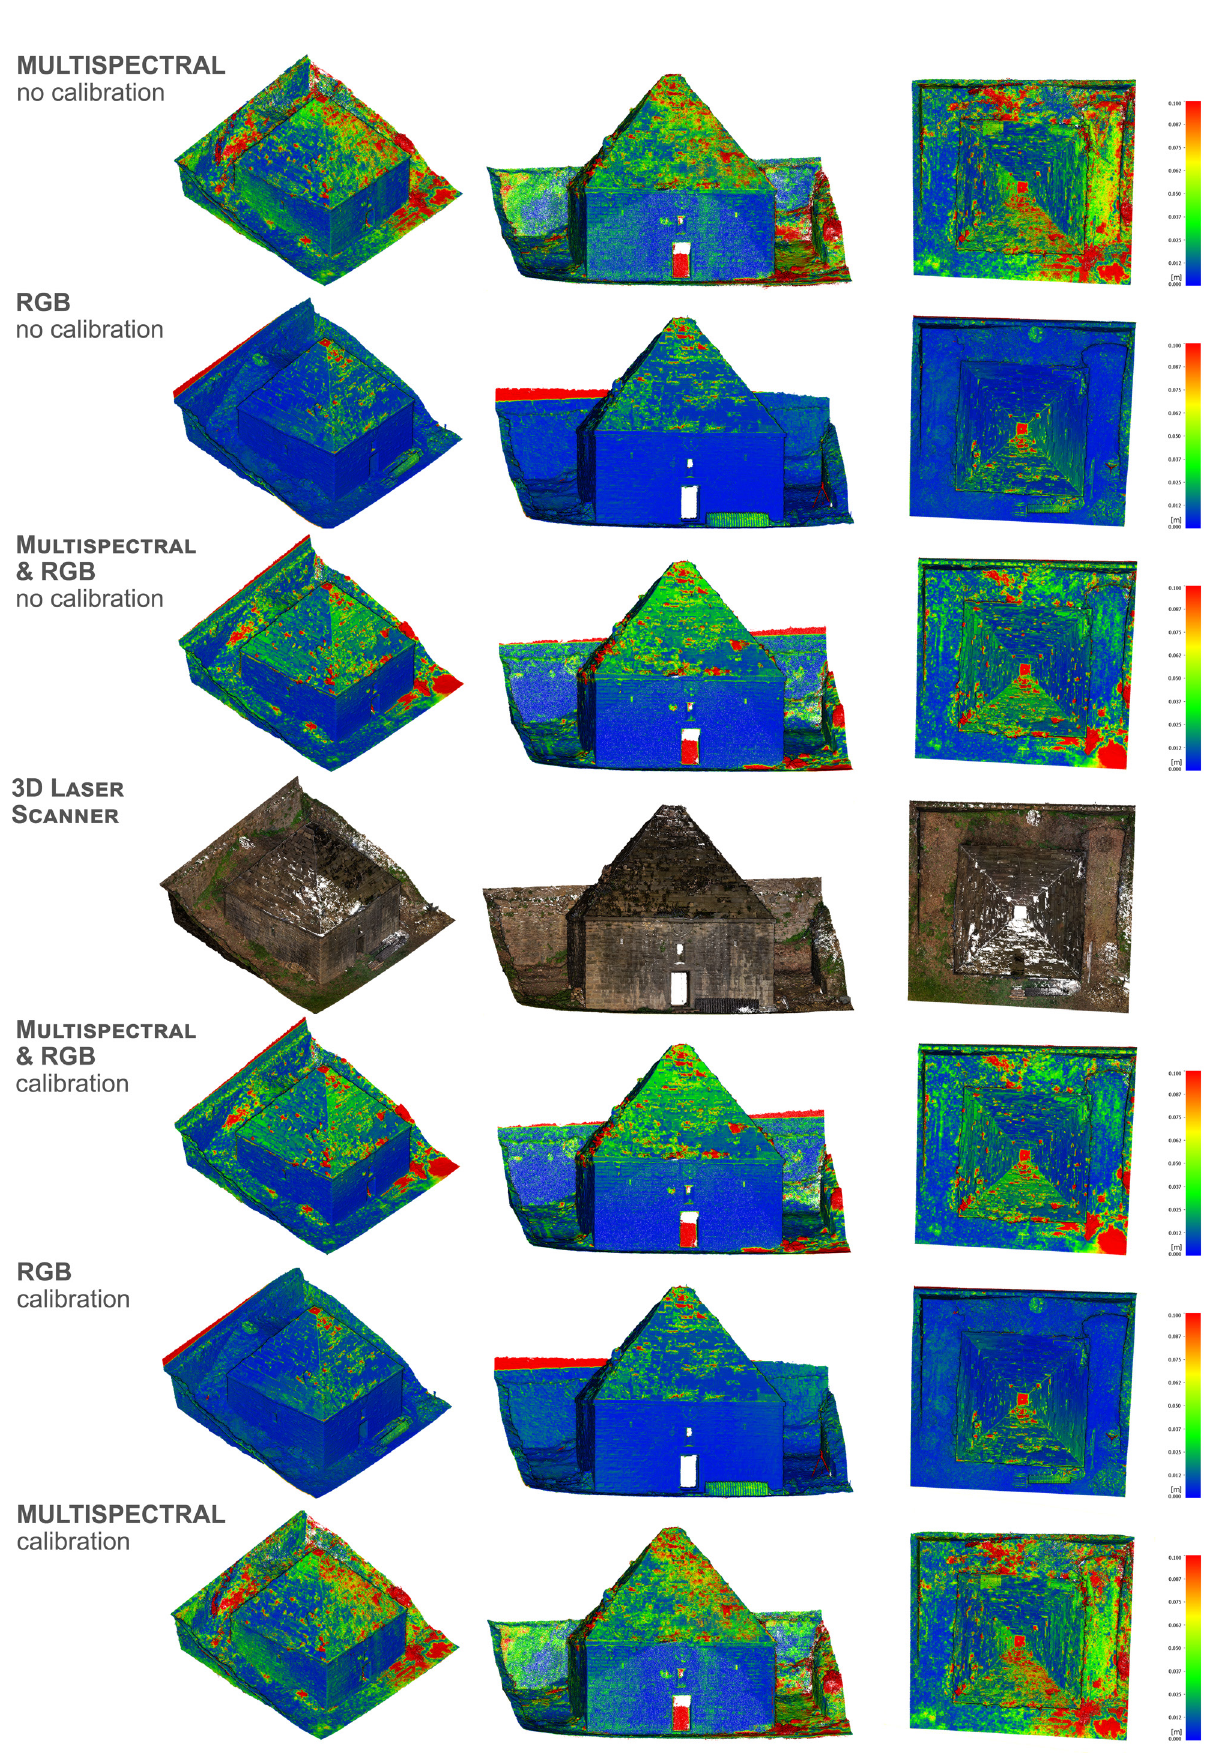
Figure 6. Comparison between the TLS model and photogrammetric models in the same reference